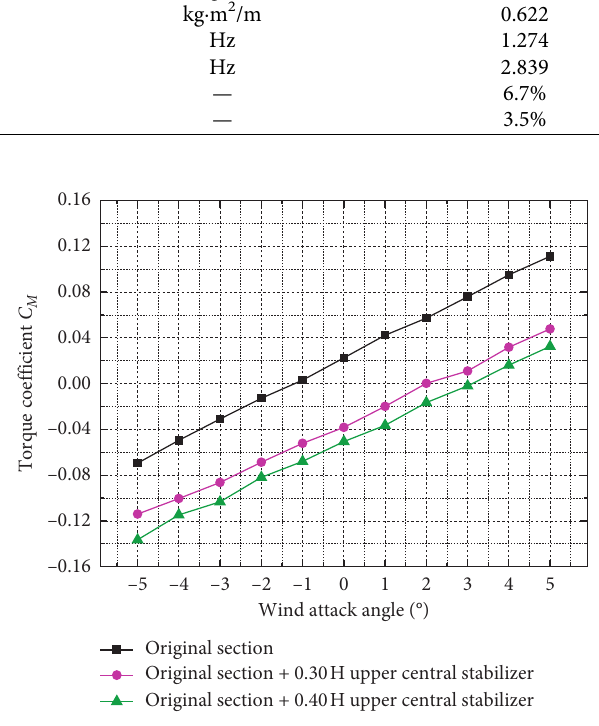
Figure 6: Torque coefficients for different wind attack angles.